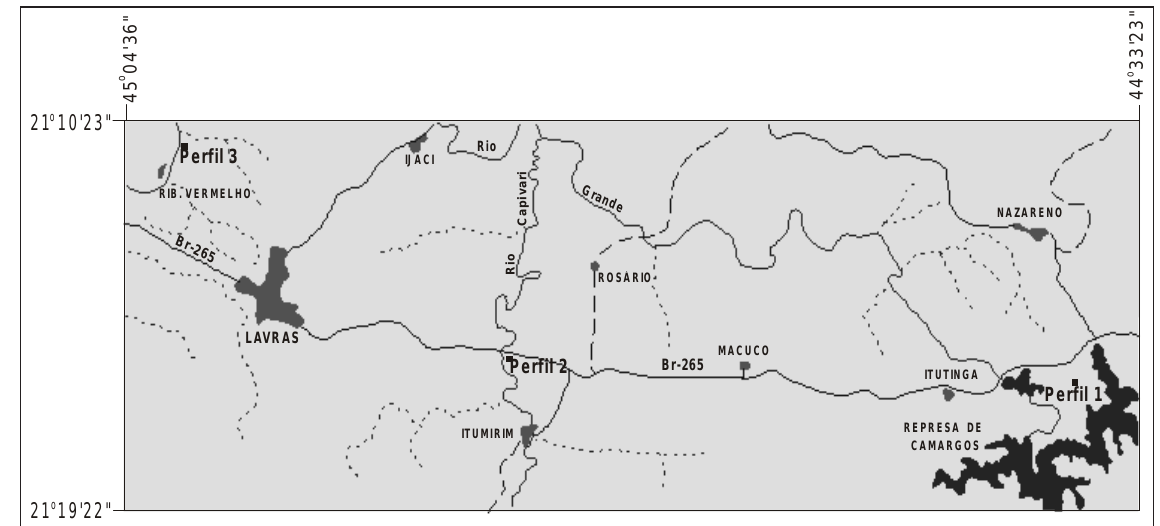
Perfil 1 - Argissolo Vermelho-Amarelo distrófico; Perfil 2 - Argissolo Vermelho eutrófico; Perfil 3 - Chernossolo Argilúvico Figura 1. Localização dos perfis estudados.